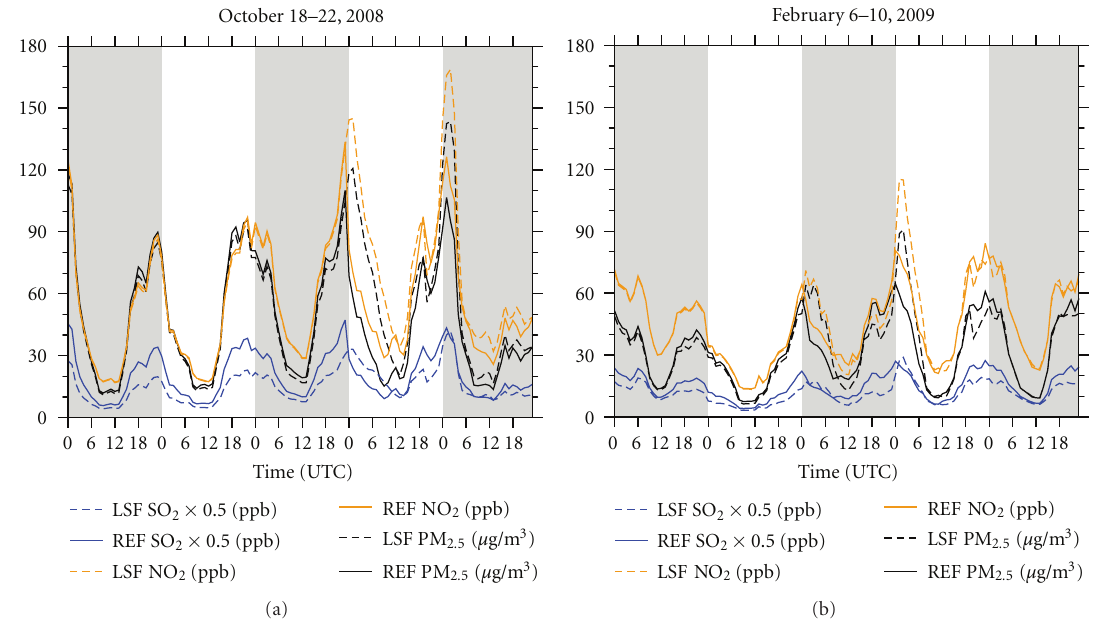
Figure 8: Mixing ratios of chemical species and PM 2 . 5 concentrations as obtained by REF and LSF for the gird cell that holds the monitoring site for October 18–22, 2008, and February 6–10, 2009 (UTC). The grey color serves to better distinguish among